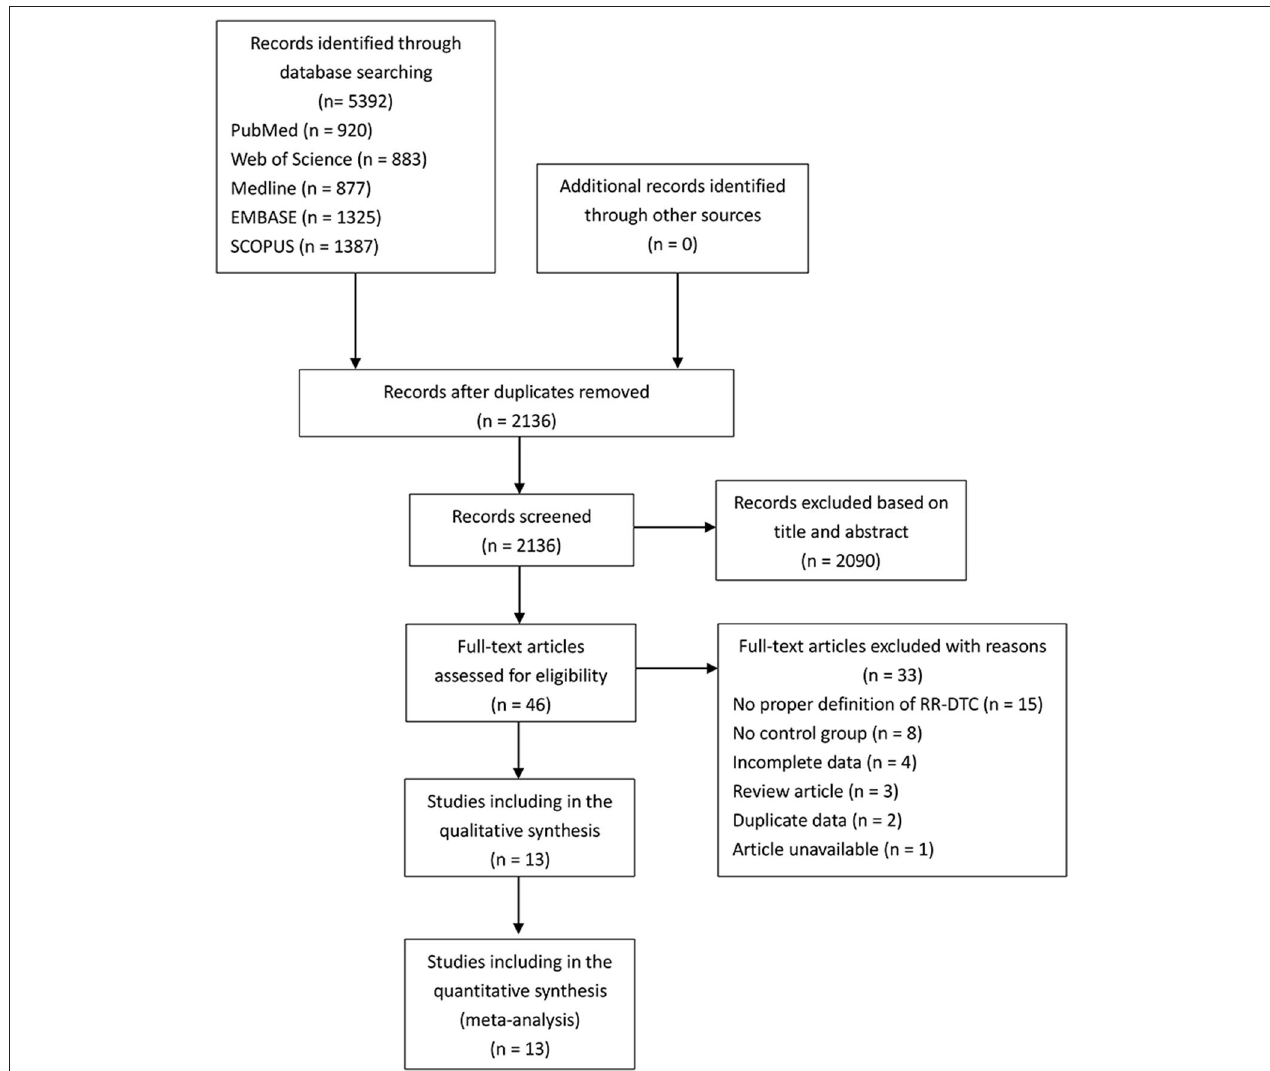
FIGURE 1 | Flow chart of the process of the study selection.